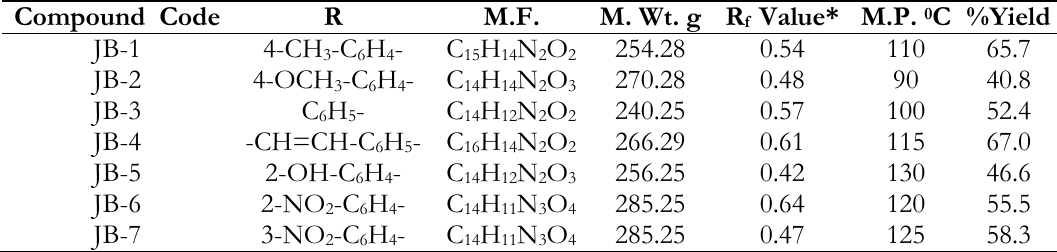
Table I. Physical constants of Azomethines Compound Code